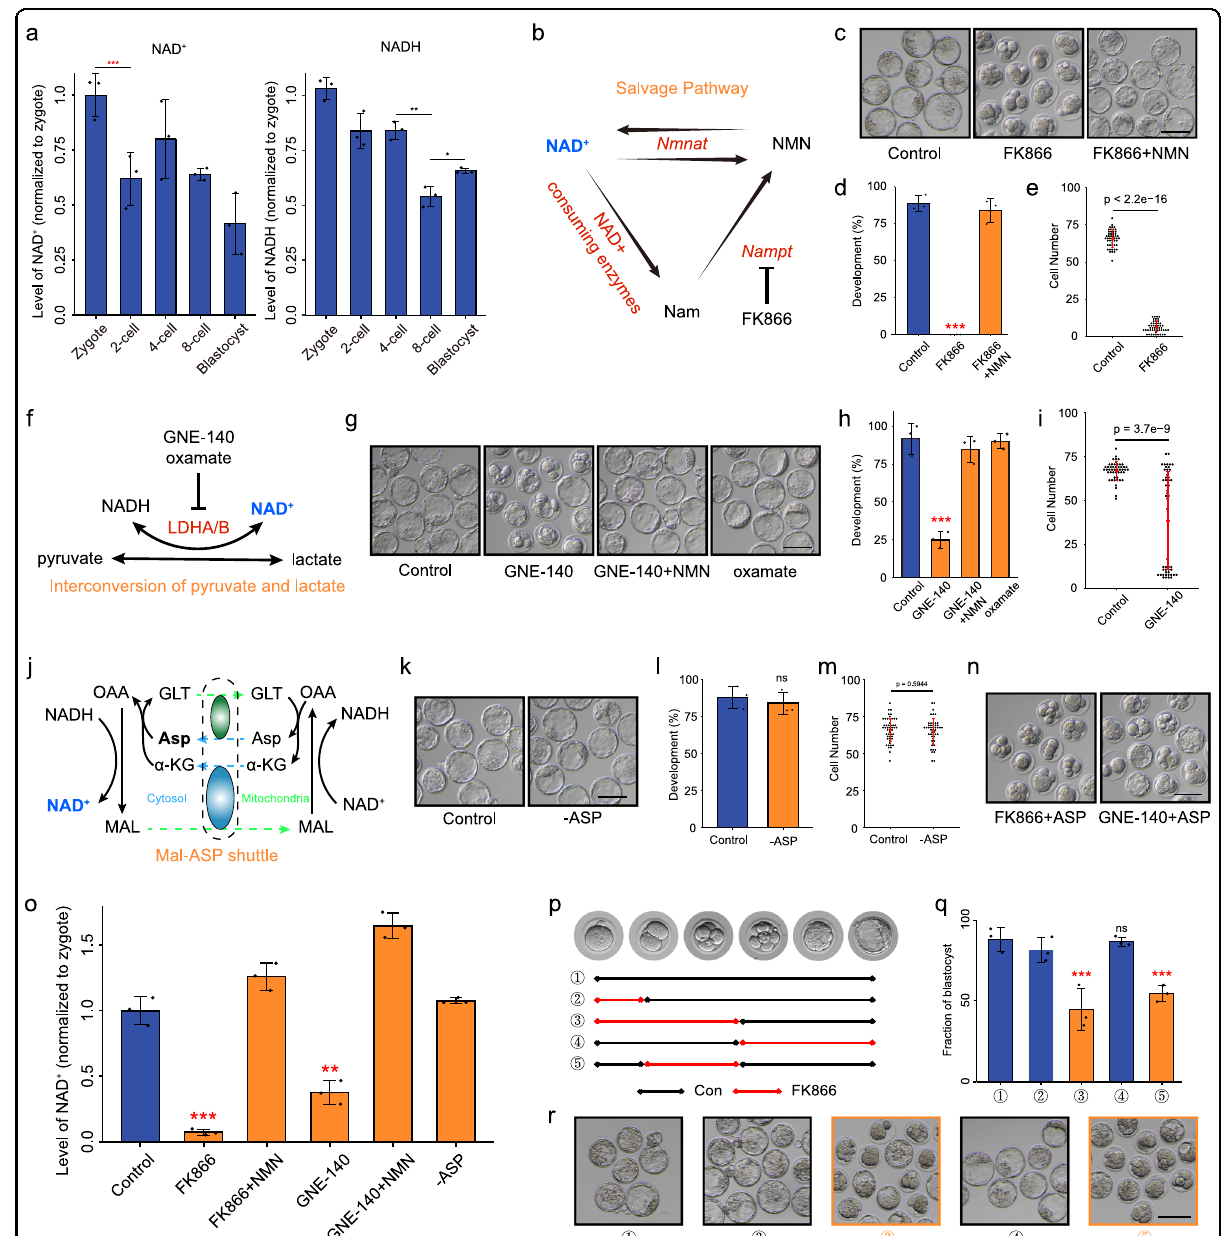
Fig. 3 NAD + depletion impairs early mouse embryo development. a NAD + and NADH levels during early mouse embryo development. b Overview of the NAM salvage pathway. c Representative images and d developmental rates of control, FK866-treated, and FK866 + NMN- supplemented embryo groups. Data are from three independent experiments. *** P < 0.001 (Student ’ s t -test). Scale bars, 50 μ m. e Quanti fi cation of cells in control and FK866-treated embryo groups. Dots represent cell numbers of single embryos. f Overview of the interconversion pathway of pyruvic acid and lactate. g Representative images and h developmental rates of control, GNE-140-treated, GNE-140 + NMN-supplemented, and oxamate-treated embryos. Data are from three independent experiments. *** P < 0.001 (Student ’ s t -test). Scale bars, 50 μ m. i Quanti fi cation of cells in control and GNE-140-treated embryos. Dots represent cell numbers of single embryos. j Overview of the Mal-Asp shuttle. GLT glutamate, MAL malate, OAA oxaloacetate. k Representative images and l developmental rates of control and Asp-deletion embryos. Data are from three independent experiments. *** P < 0.001 (Student ’ s t -test). Scale bars, 50 μ m. m Quanti fi cation of cells in control and Asp-deletion embryos. Dots represent cell numbers of single embryos. n Development of FK866- and GNE-140-treated embryos supplemented with Asp. o NAD + level in control, FK866- treated, FK866 + NMN, GNE-140-treated, GNE-140 + NMN, and Asp-deletion late 2-cell embryos. p – r Timeline of FK866 treatment. Embryos were cultured in control or FK866-addition medium. The stages of FK866 treatment are indicated in ( p ). Developmental rates q and representative images r of each group are shown. Data are from three independent experiments. ** P < 0.01, *** P < 0.001 (Student ’ s t -test). Scale bars, 50 μ